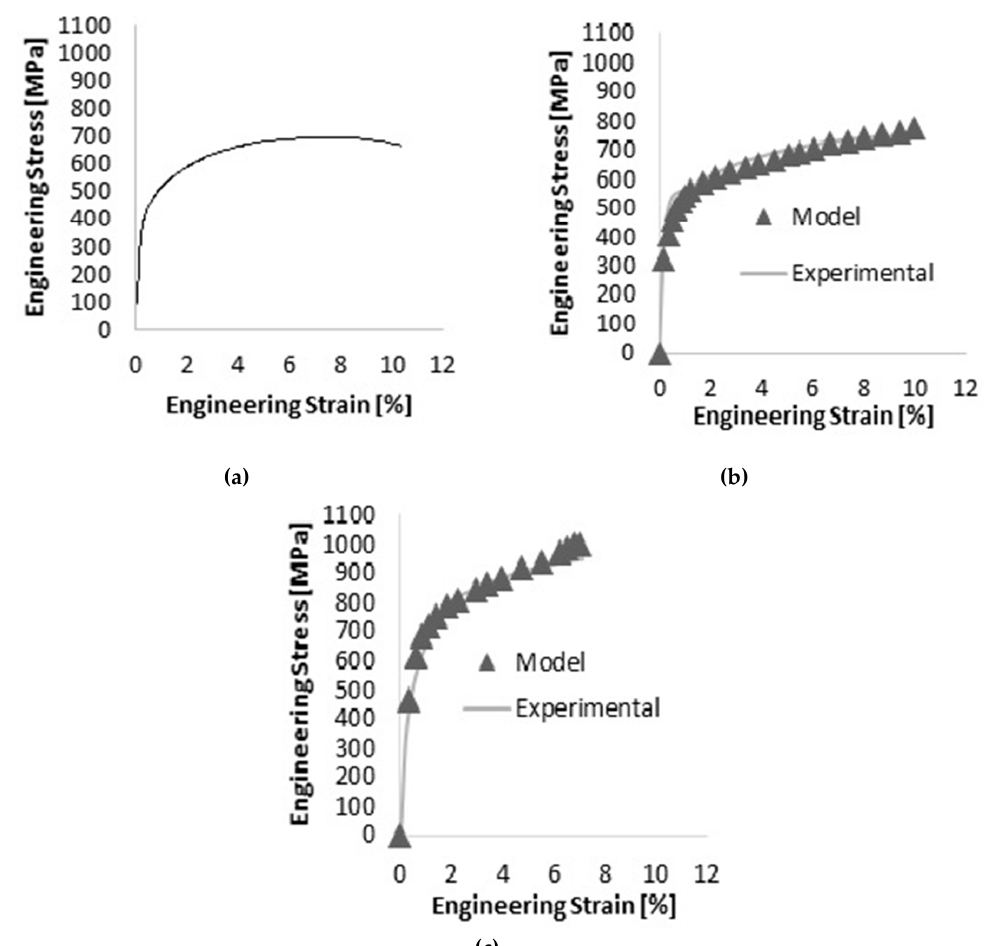
Figure 3. Experimental and predicted engineering stress–strain curves of ( a ) DP0, ( b ) DP1 and ( c ) DP2 steels.